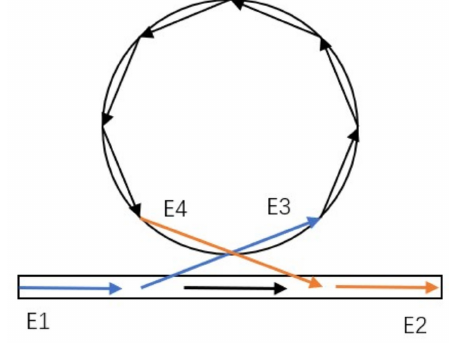
Figure 3. Model of cavity-waveguide